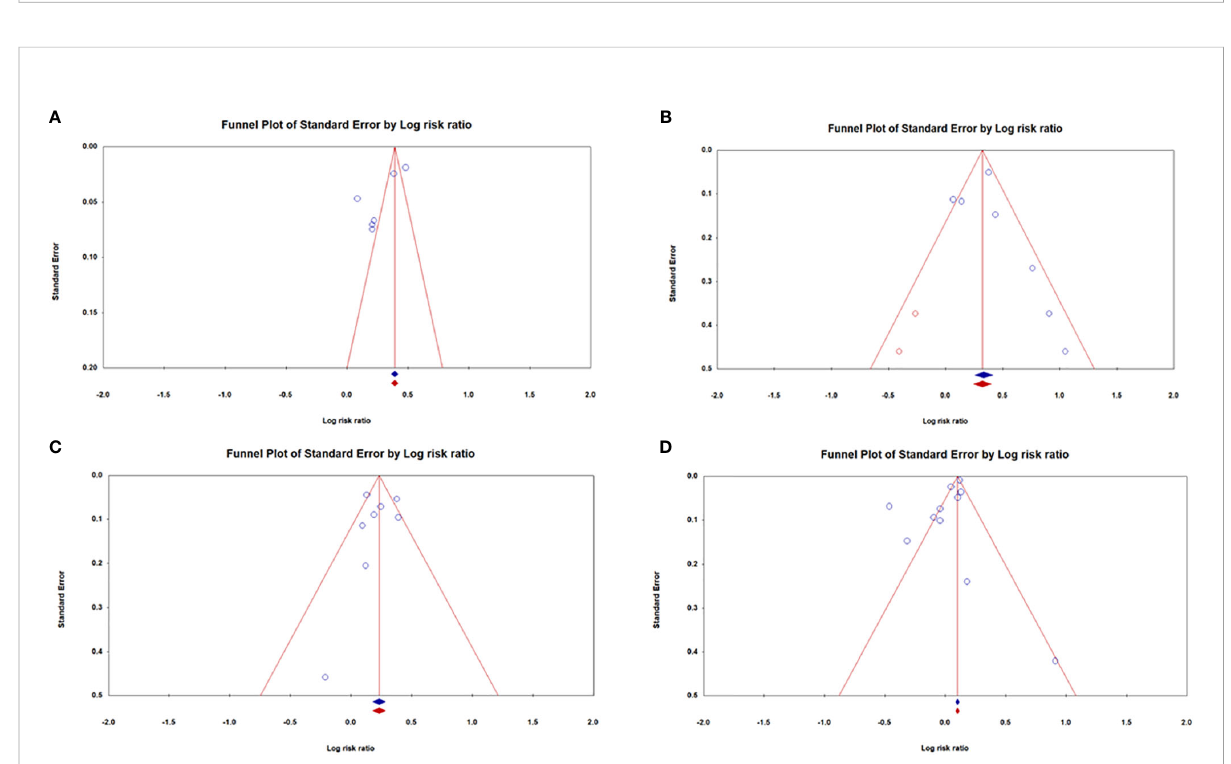
FIGURE 7 Funnel plotsfortheassociationbetweendementiariskand (A) OA, (B) SLE, (C) SS, and (D) RAafterusingatrim-and- fi ll methodtodiminish the consequencesof existingpublication